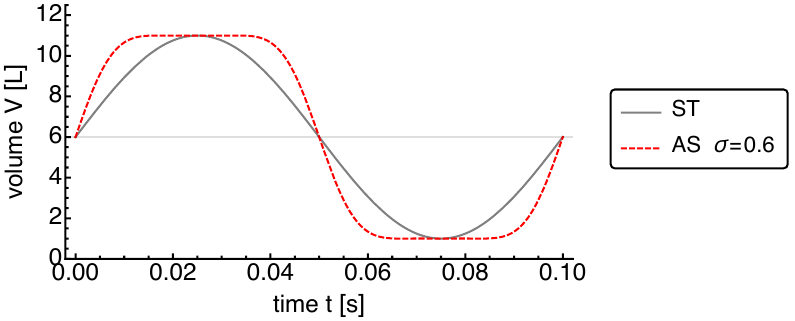
Figure 1. Comparison of the cylinder volume over time V ( t ) for the “standard harmonic motion” ST (solid line) and “adjustable sinusoidal motion” AS (dashed line) for t 0 = 0.1s with δ = 0 and σ = 0.6. For the AS motion with σ > 0, the maximum volume speed (e.g., around t = 0.05s) increases, while the piston speed around the volume extrema